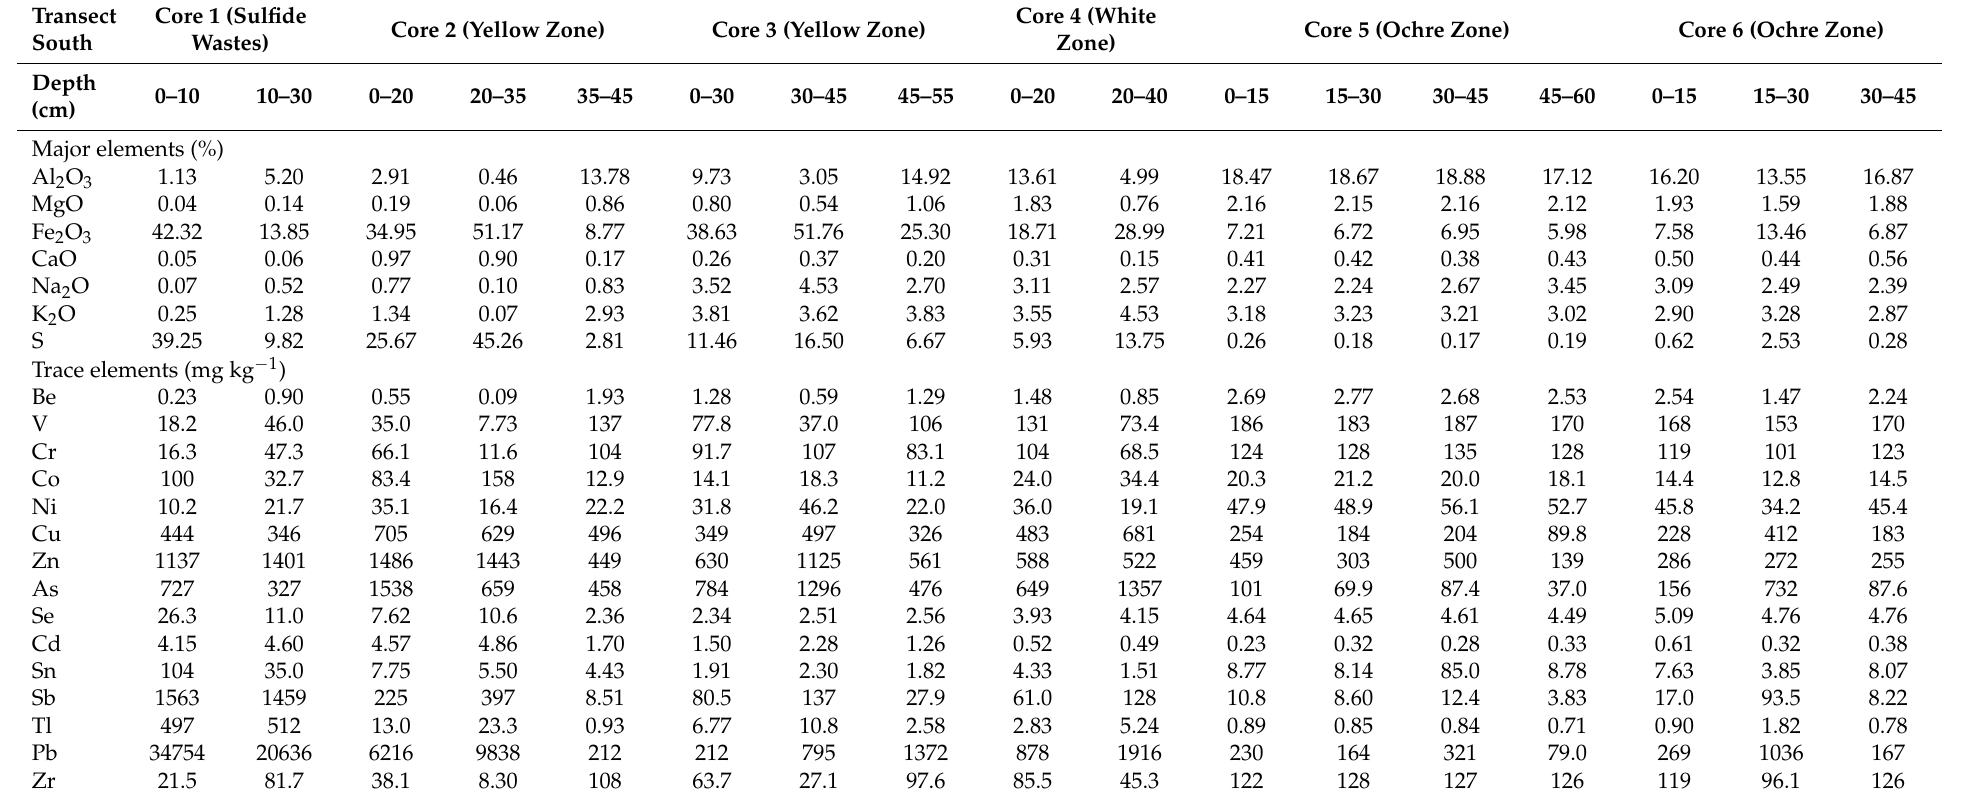
Table 3. Chemical composition of major and trace elements of the soil core samples collected along the south